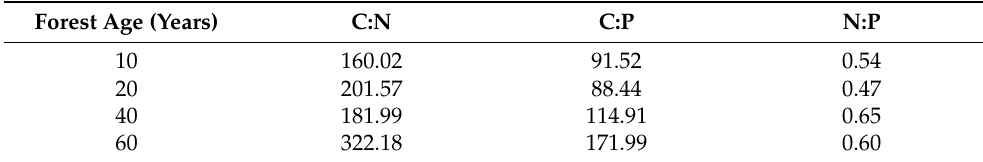
Table 2. Soil stoichiometric mean value in forests of different ages. C:N, C:P, and N:P represent the ratios of soil total organic carbon to total nitrogen, total organic carbon to total phosphorus, and total nitrogen to total phosphorus,